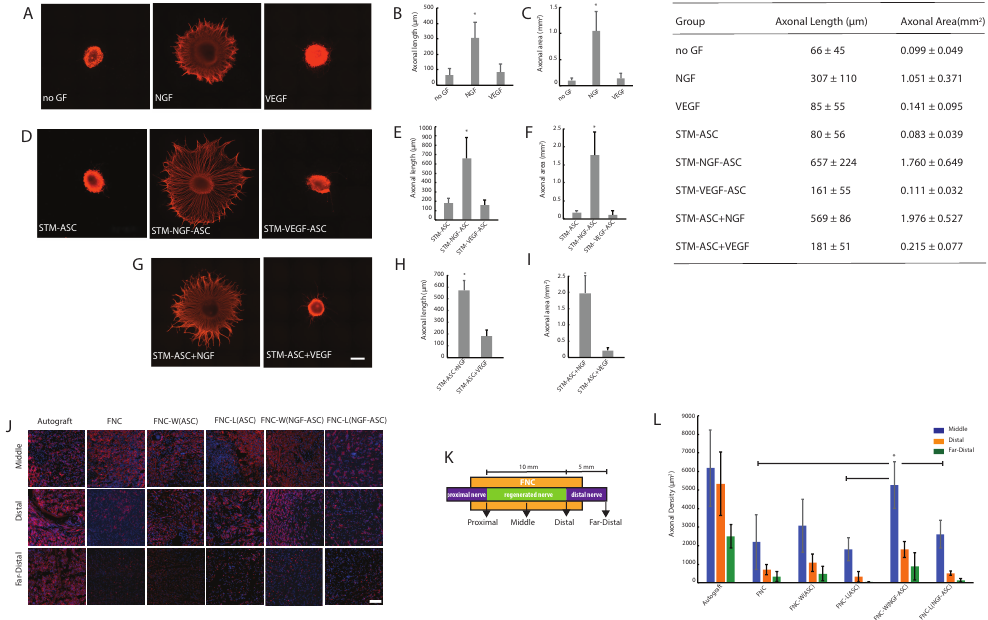
Figure2. Fibrinassisteddeliveryofstimulatedstemcellsforaxonalregeneration: ( A )Microphotographs of DRG-explant cultures treated with growth factors. ( B ) Quantitative measurements of axonal length. ( C ) Quantitative measurements of the axonal area. ( D ) Microphotographs of DRG-explant cultures that were treated with secretome derived from unstimulated ASC (STM-ASC) or NGF-stimulated ASC (STM-NGF-ASC) or VEGF-stimulated ASC (STM-VEGF-ASC). ( E ) Quantitative measurements of axonal length. ( F ) Quantitative measurements of the axonal area. ( G ) Microphotographs of DRG-explant cultures that were treated with ASC’s secretome in combination with exogenous NGF (STM-ASC + NGF) or VEGF (STM-ASC + VEGF). ( H ) Quantitative measurements of axonal length. ( I ) Quantitative measurements of the axonal area. For images ( A )–( I ), the scale bar represents 500 µ m and the bars represent mean ± SD of n = 8. Significant di ff erences at * p < 0.05 are indicated in comparison to all other treatment groups. ( J ) Microphotographs showing the β -Tubulin III + axons for various experimental groups: Autograft; empty fibrin-hydrogel nerve conduit “FNC”; FNC’s wall loaded with unstimulated ASC, i.e., intramural ASC delivery “FNC-W(ASC)”; FNC’s lumen loaded with unstimulated ASC, i.e., intraluminal ASC delivery “FNC-L(ASC)”; FNC’s wall loaded with NGF-stimulated ASC, i.e., intramural NGF-ASC delivery “FNC-W(NGF-ASC)”; FNC’s lumen loaded with NGF-stimulated ASC, i.e., intraluminal NGF-ASC delivery “FNC-L(NGF-ASC)”. The scale bar represents 100 µ m. ( K ) Anatomical segmentation representing the histological analysis of the reconstructed nerves. ( L ) Quantitative measurements of β -Tubulin III + axons for various experimental groups: Autograft; empty fibrin-hydrogel nerve conduit “FNC”; FNC’s wall loaded with